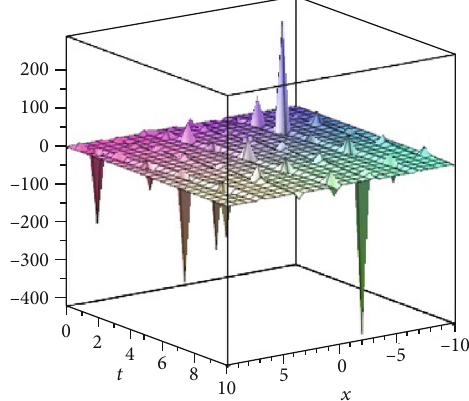
ð x , 0, t Þ of Equation (21). Figure 4: u 2,3